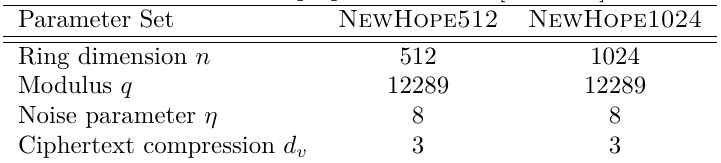
Table 3: NewHope parameter sets [PAA + 19] Parameter